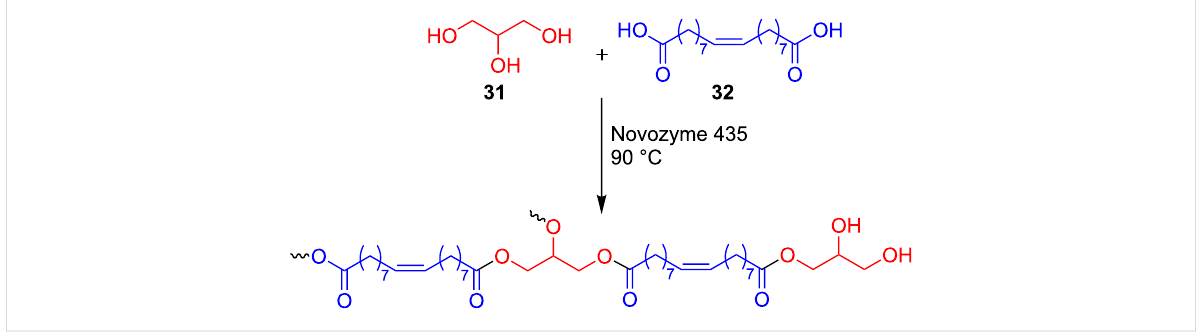
Figure 10: Biocatalyzed synthesis of polyesters containing glycerol.